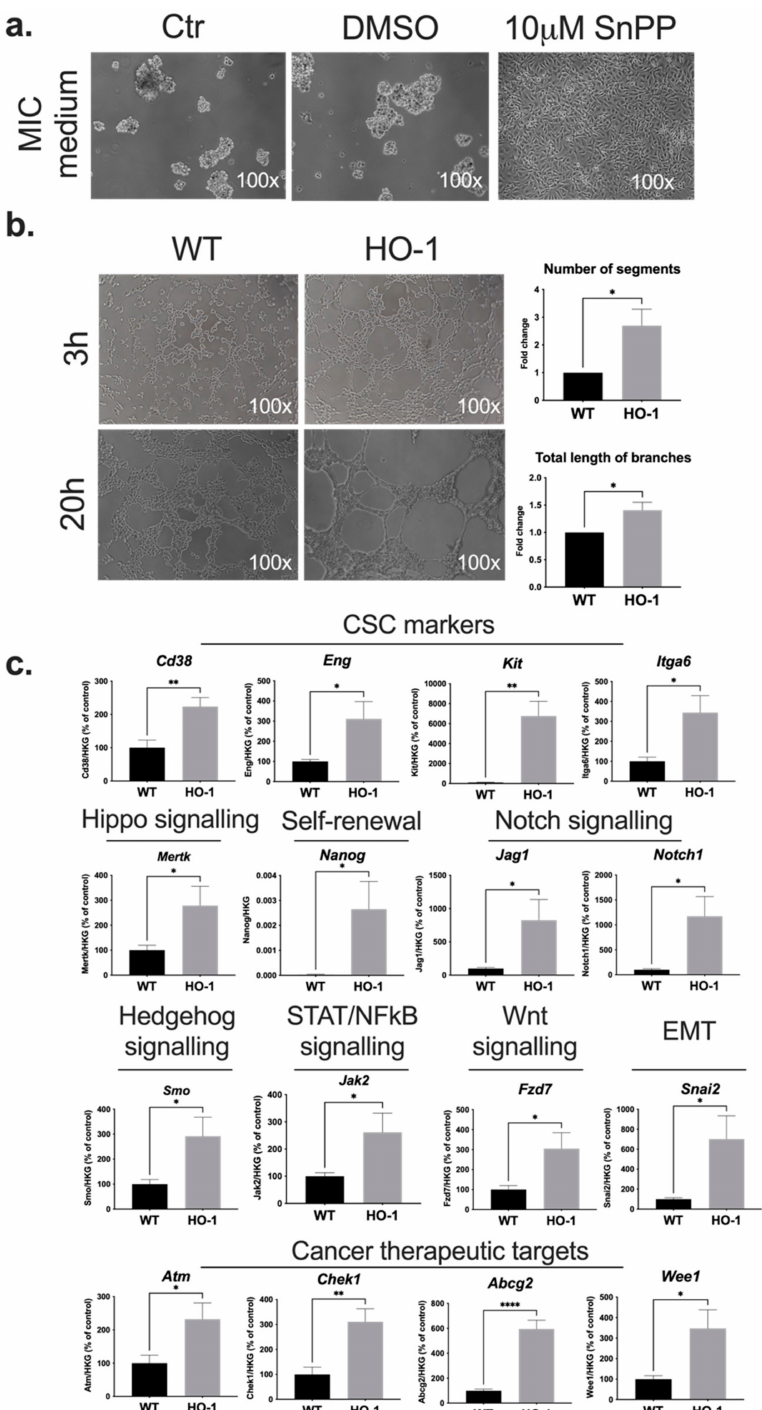
Figure 1. HO-1 overexpression affects CSC-like properties of B16-F10 melanoma cells. ( a ) Repre- sentative microscopic pictures of B16-F10 cells cultured 7 days in MIC medium: Ctr, MIC medium; DMSO, MIC medium supplemented with DMSO as a diluent control; 10 µ M SnPP, MIC medium supplemented with 10 µ M tin protoporphyrin IX (n = 4). ( b ) In vitro Matrigel-based tube formation assay. B16-F10 WT and HO-1 cells were seeded on Matrigel matrix and monitored 3 h and 20 h after seeding. Image J analysis using Angiogenesis Analyzer plugin was performed using pictures taken 3 h after cell seeding (n = 5, each bar represents mean fold change + SEM). ( c ) RT 2 Profiler Array (Qiagen) of CSC-associated genes performed on B16-F10 WT and HO-1 cells (HKGs, housekeeping genes; n = 4–5; each bar represents mean + SEM; * p < 0.05, ** p < 0.01, **** p <